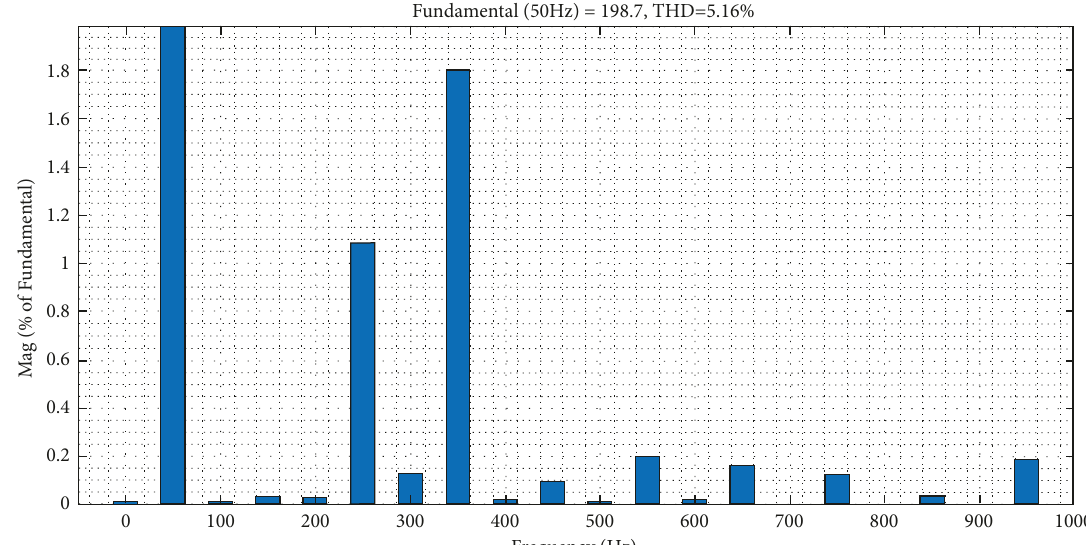
Figure 11: THD for grid side current for PI with phase-shifted technique.